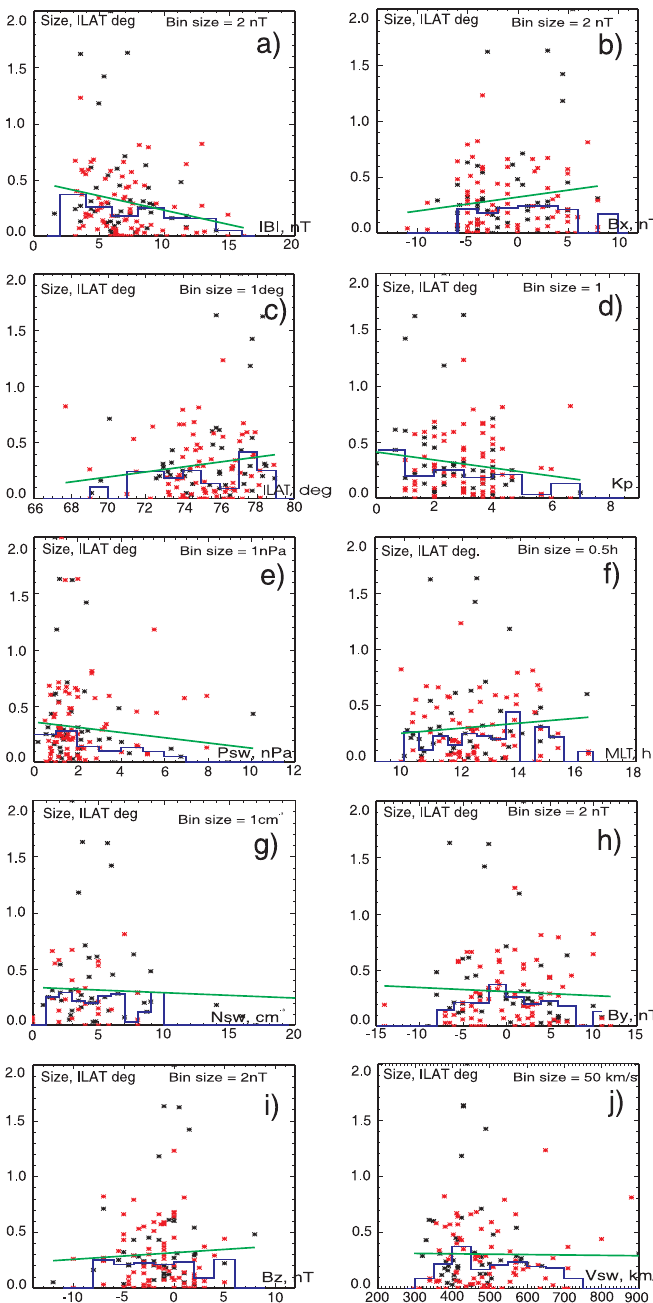
Fig. 8. Dependencies of the size of the electron edge of the LLBL on external parameters: the magnitude of the IMF (panel a ), the IMF B X -component (panel b ), the invariant latitude of observations ILAT (panel c ), the geomagnetic index K p (panel d ), the dynamic pressure of the solar wind (panel e ), the Magnetic Local Time (MLT) of the observation (panel f ), the solar wind density (panel g ), the B Y - and B Z - components of IMF (panels h and i ) and the solar wind velocity (panel j ). The GSM coordinate system has been used. The panels are listed in order of the strength of the dependency of the electron edge size on the external parameter: i.e. panel (a) shows the best dependency and panel (j) shows the worst dependency. In each panel, the red points represent events where the size was estimated from the multi-spacecraft method, while the black points represent events where the size was estimated from the one-spacecraft method. The green line shows a linear least squares fit to these data, while the blue line shows the median value of the size in each bin, for cases where there are more than 3 points in a